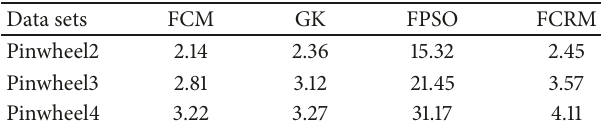
Table 3: Average execution time (in seconds) for FCM, GK, FPSO, and FCRM with fixed clusters